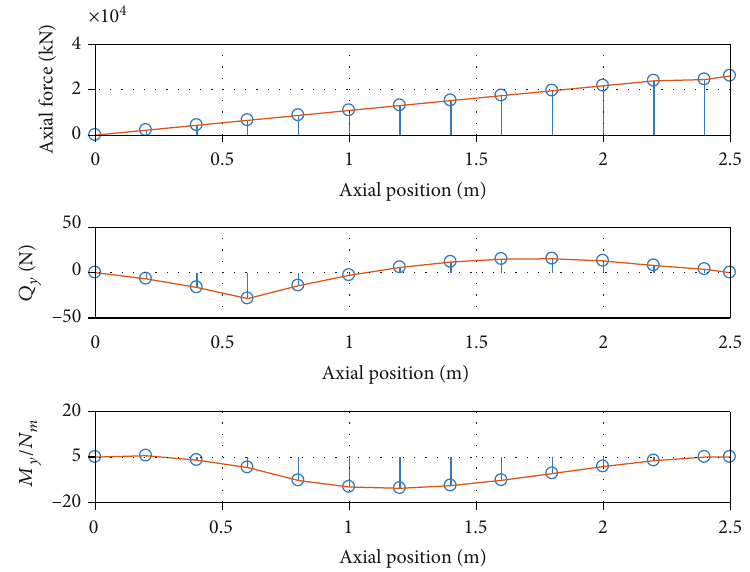
Figure 12: The axial force, shear force, and bending moment at 45 s with basic Table 2: Basic PSO compare with improved PSO. Algorithms